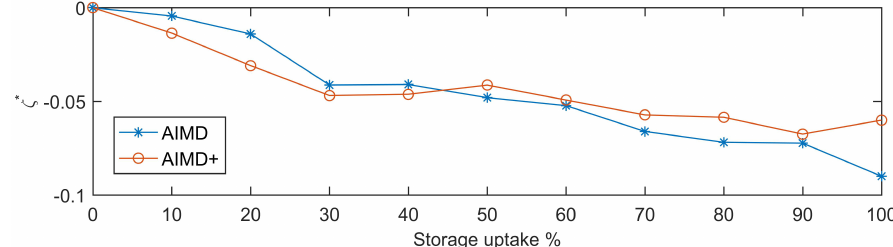
Figure 9. Average ζ ∗ storage uptake.